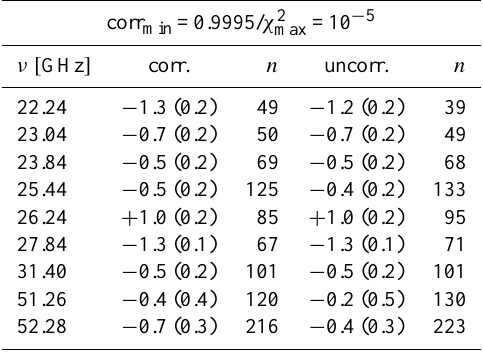
Table 4. Difference ( 1T b ) of mean zenith T b (standard deviation) [K] from successful tipping curve calibrations (TIP) on 16 Au- gust 2009 to T b values based on the LN 2 calibration on 11 Au- ent quality control thresholds within the tipping curve calibration (Sect. 4.2.5). n is the number of averaged successful tipping curve calibrations on 16 August 2009. Results from calibrations including a beam width correction and an exact air mass calculation are given in column “corr.”. The uncorrected results are given in column “un- corr.”.